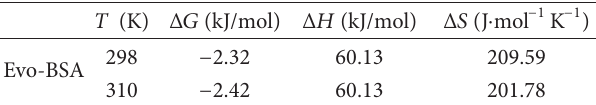
T 4: e temperature-dependent thermodynamic parameters for the Evo-BSA